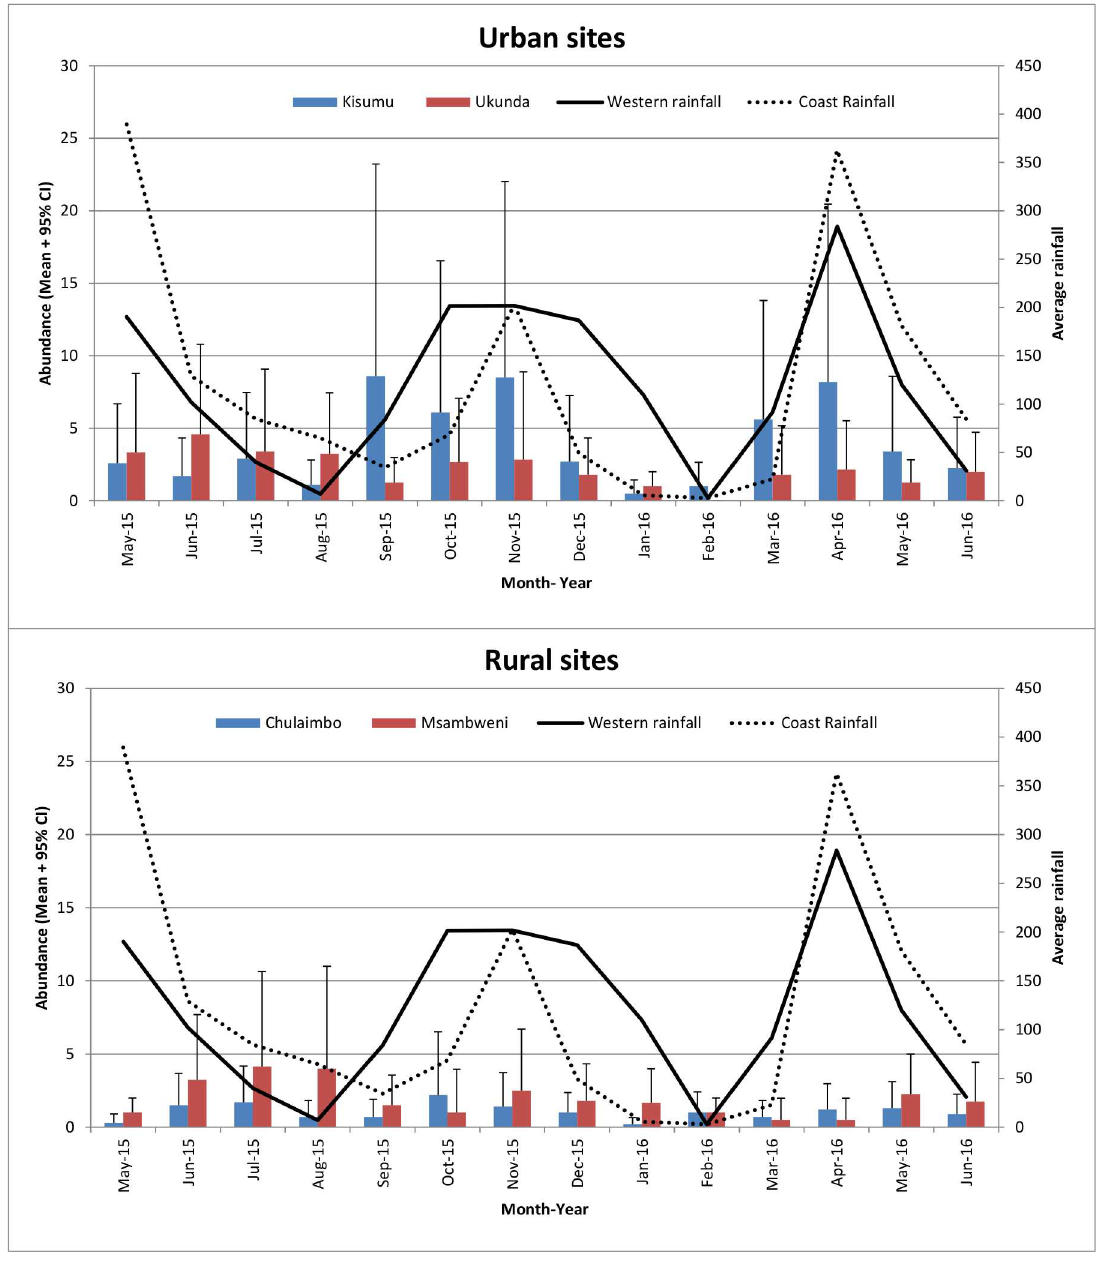
Fig 4. Mean numbers + 95% CI of Aedes aegypti mosquitoes collected by Bio-Gents sentinel trap.